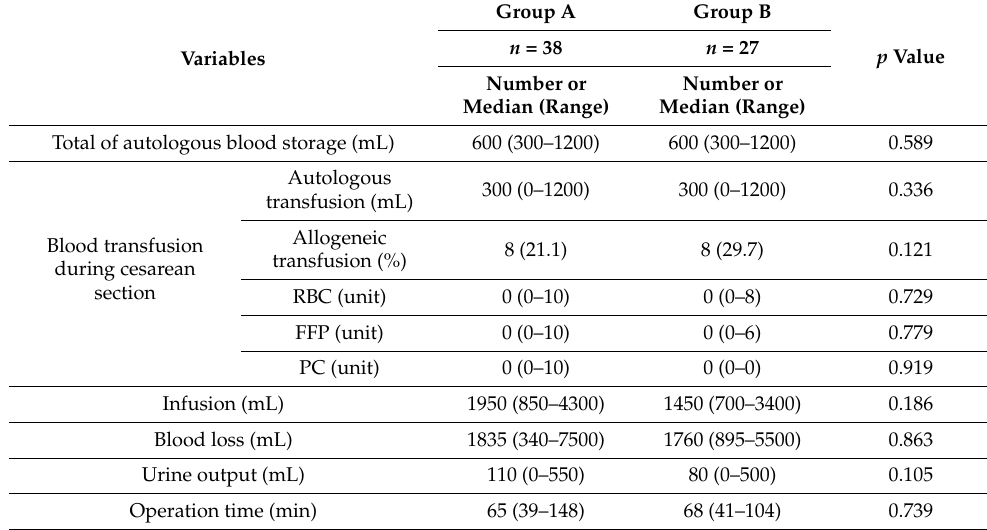
Table 2. Operative outcomes of both groups.